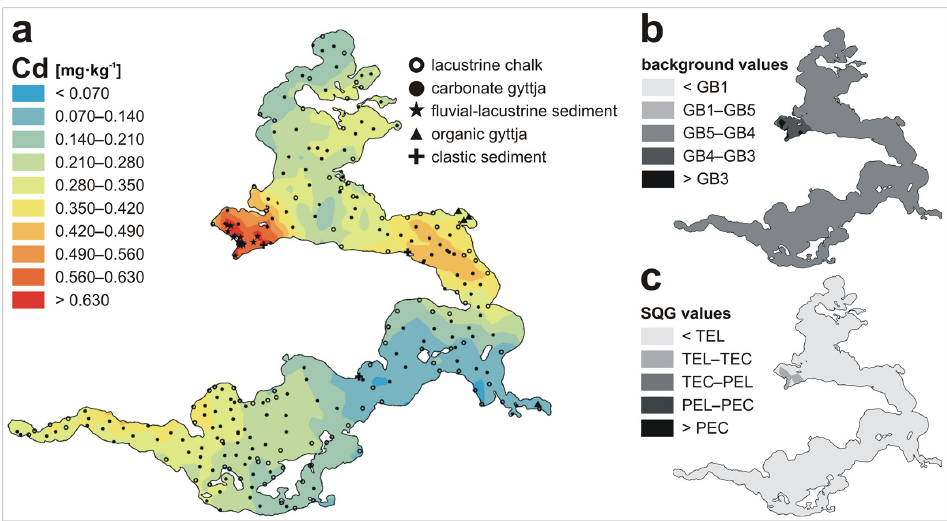
Figure 5. Cadmium in recent bottom sediments of the Wigry Lake: ( a ) spatial distribution of Cd; ( b ) Cd mapped according to different geochemical background values implemented in the study (Table 3); ( c ) Cd mapped according to sediment quality guideline values (TEL—threshold effect level, TEC—threshold effect concentration, PEL—probable effect level, PEC—probable effect concentration [59,60]; Table 3).